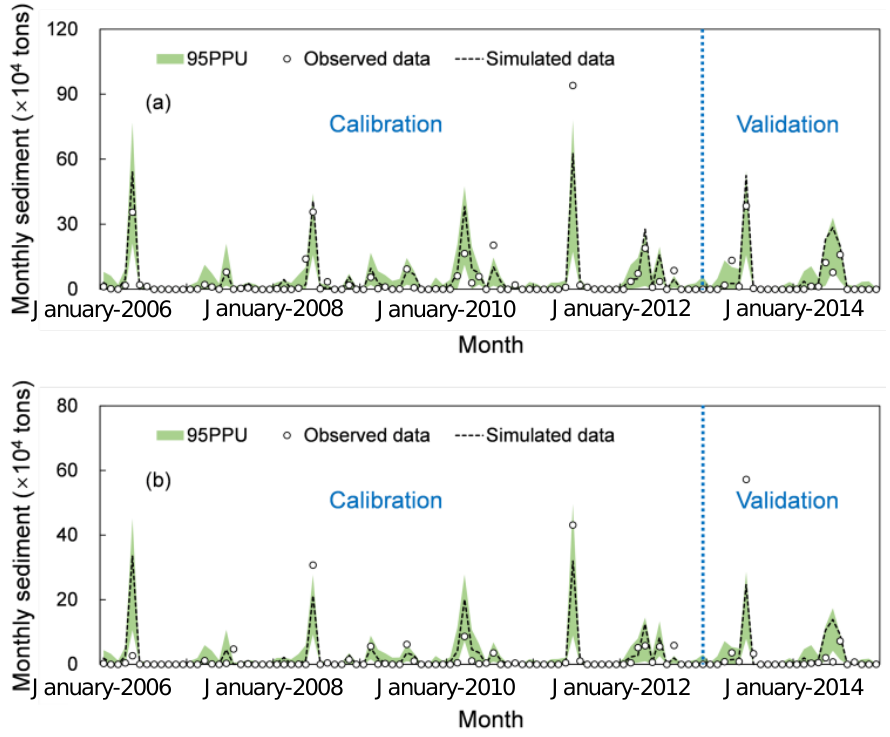
Figure 6. The comparison between the observed and modeled monthly transported sediment in XRB during the calibration (2006–2012) and validation (2013–2014) periods. ( a ) The comparison result for Tunxi Station; ( b ) the comparison result for Yuliang Station. Table 4. The results of separating the impacts of climate change and land use/land cover change on the sediment in the